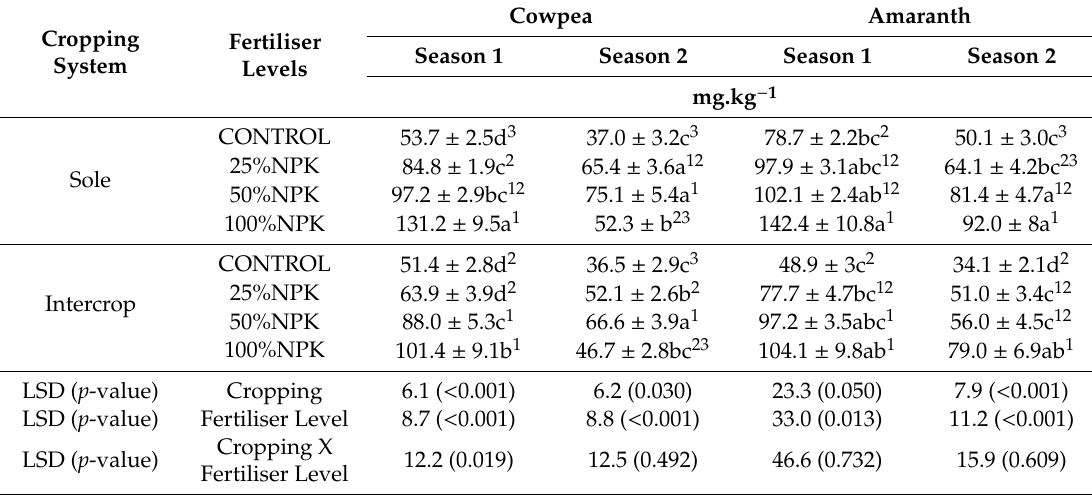
Table 3. Soil P concentration in cowpea and amaranth fertilised with four levels of nitrogen, phosphorus and potassium (NPK) in 2014 / 15 (season 1) and 2015 / 16 (season 2)